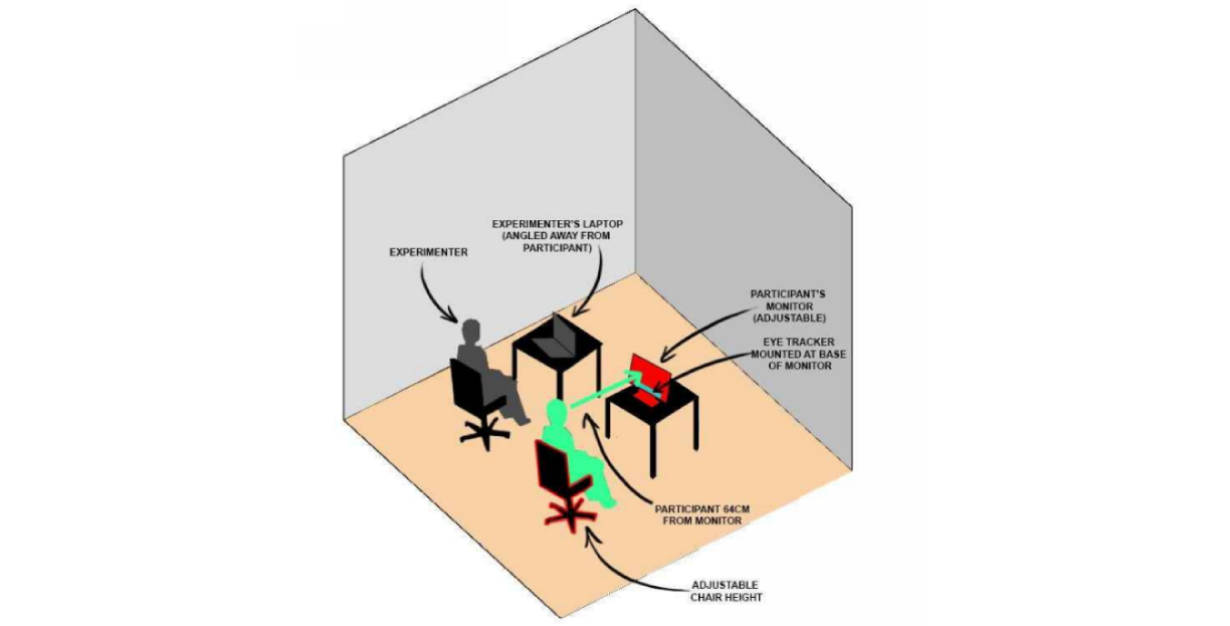
Figure 1. Physical layout of experiment and